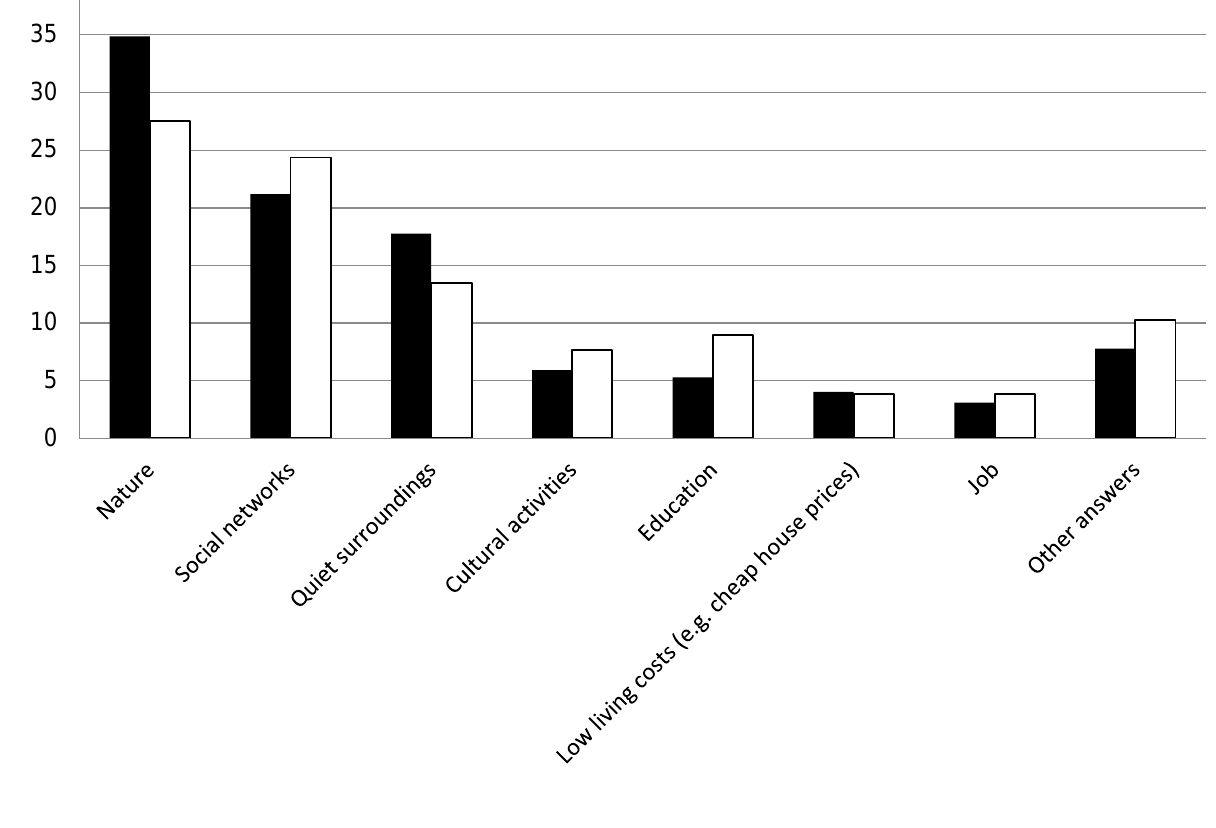
0510152025303540 All respondents Respondents of 19-35 years of Figure 3. “What did you find most attractive in Lemvig Municipality?” Percentage distribution of 321 answers from all 120 outmigrants (total sample) compared with 156 responses from 88 outmigrants of 19-35 years of age, 2011